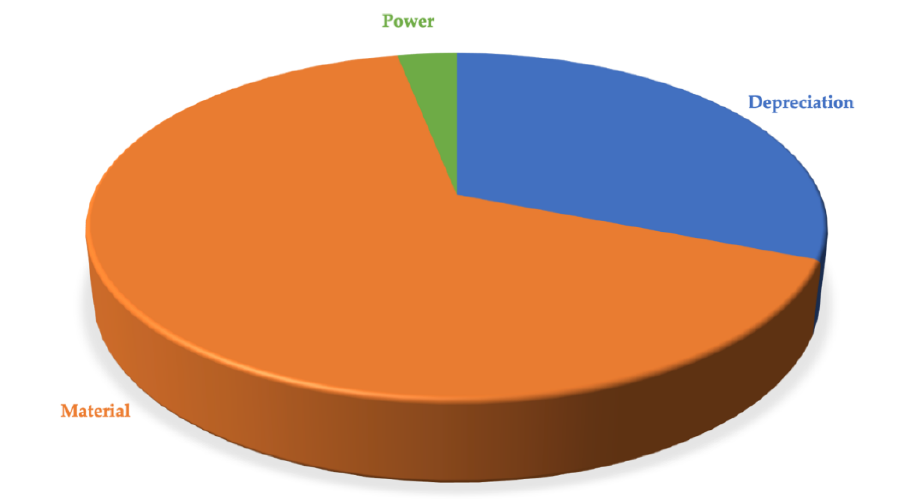
Figure 16. Pie chart relating to the cost allocation of total cost in the cost